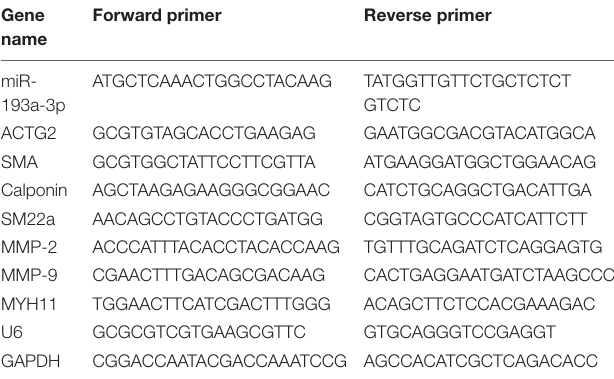
TABLE 2 | The primers in this